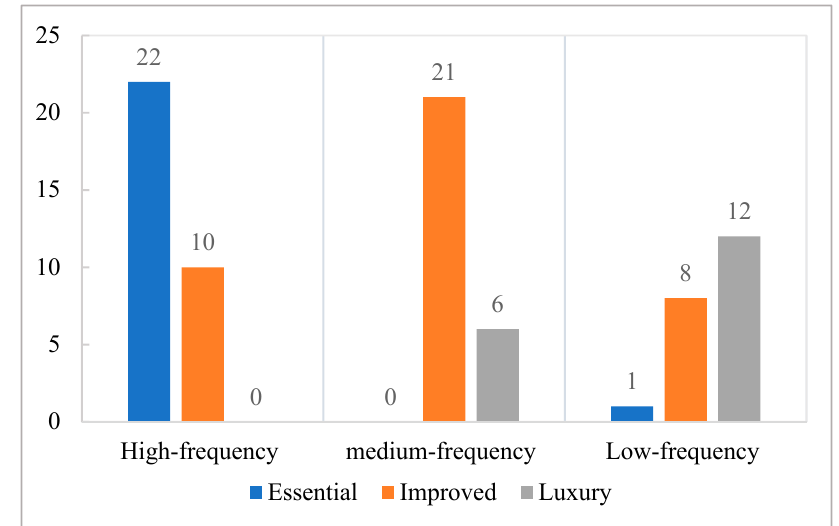
Figure 2. Type distribution of household appliances.